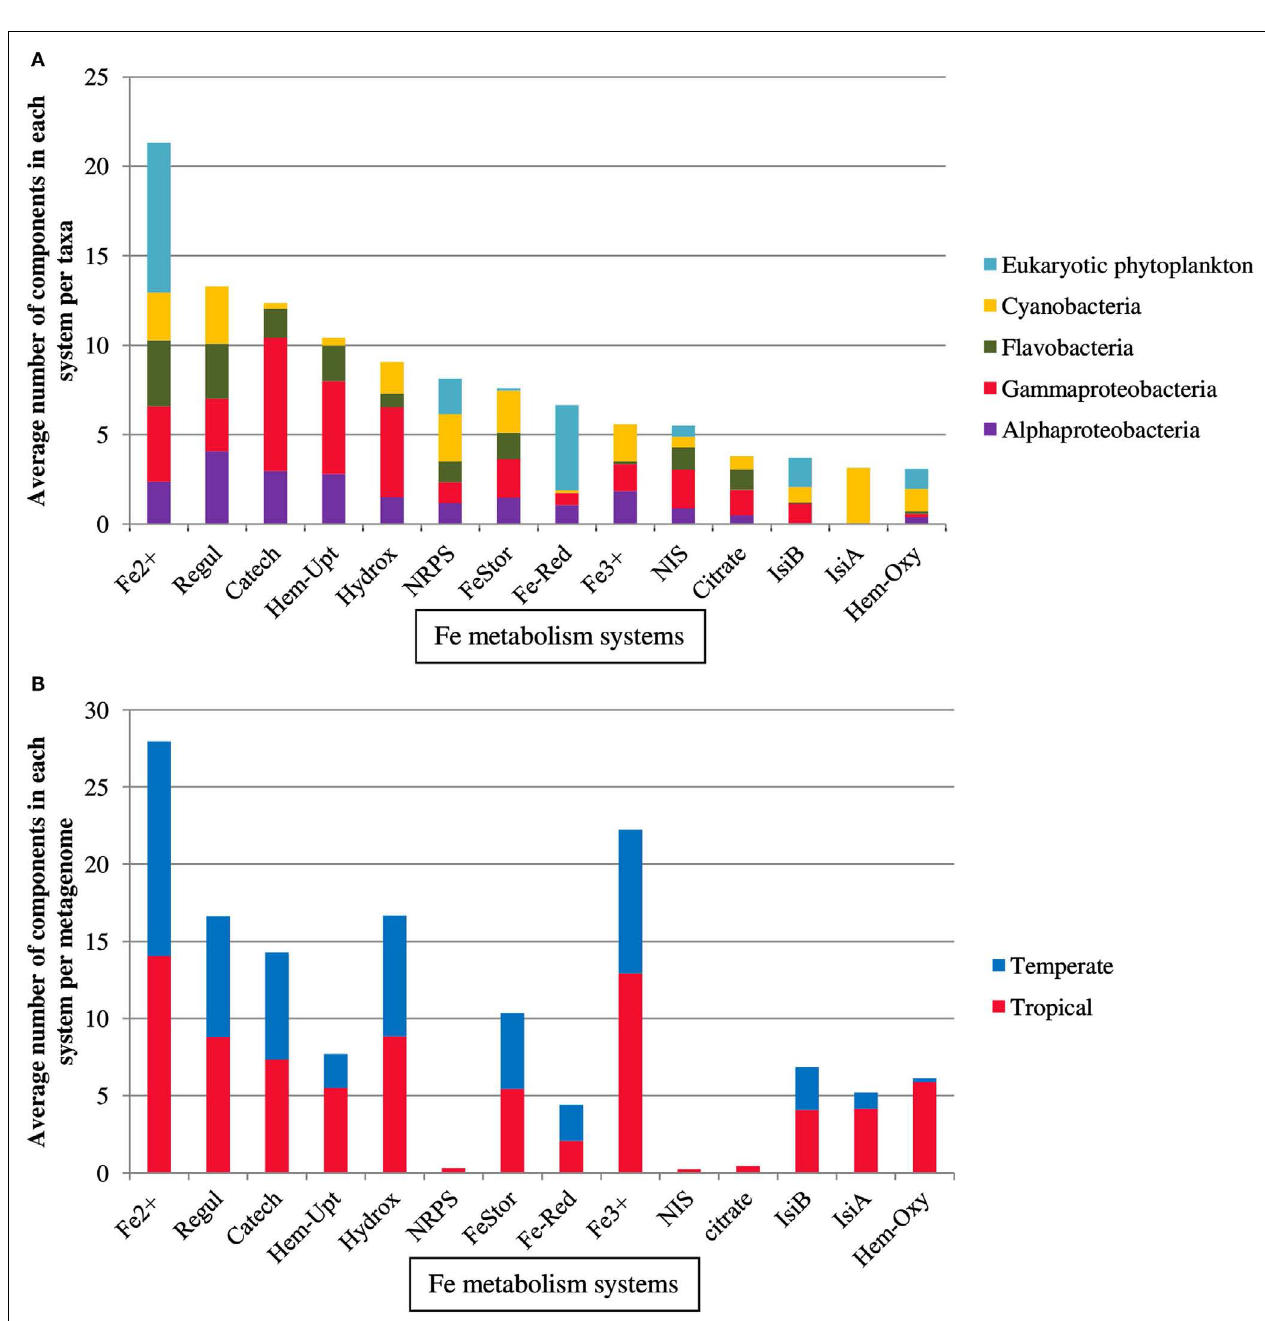
FIGURE 1 | Distribution of components of Fe-metabolism systems in (A) marine microbial taxa and (B)Temperature groupings of metagenomes. For detailed description of the components of each system see Table 1 .